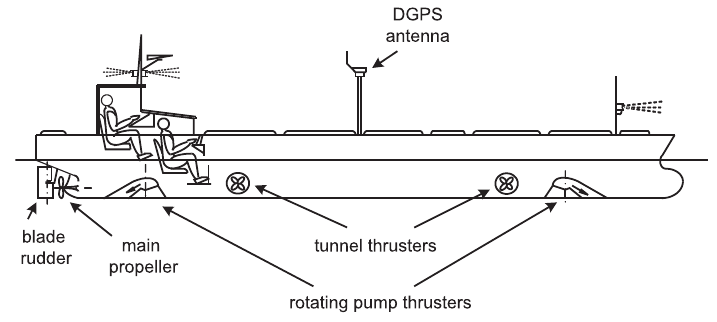
Figure 1. The outline of the training ship ‘Blue